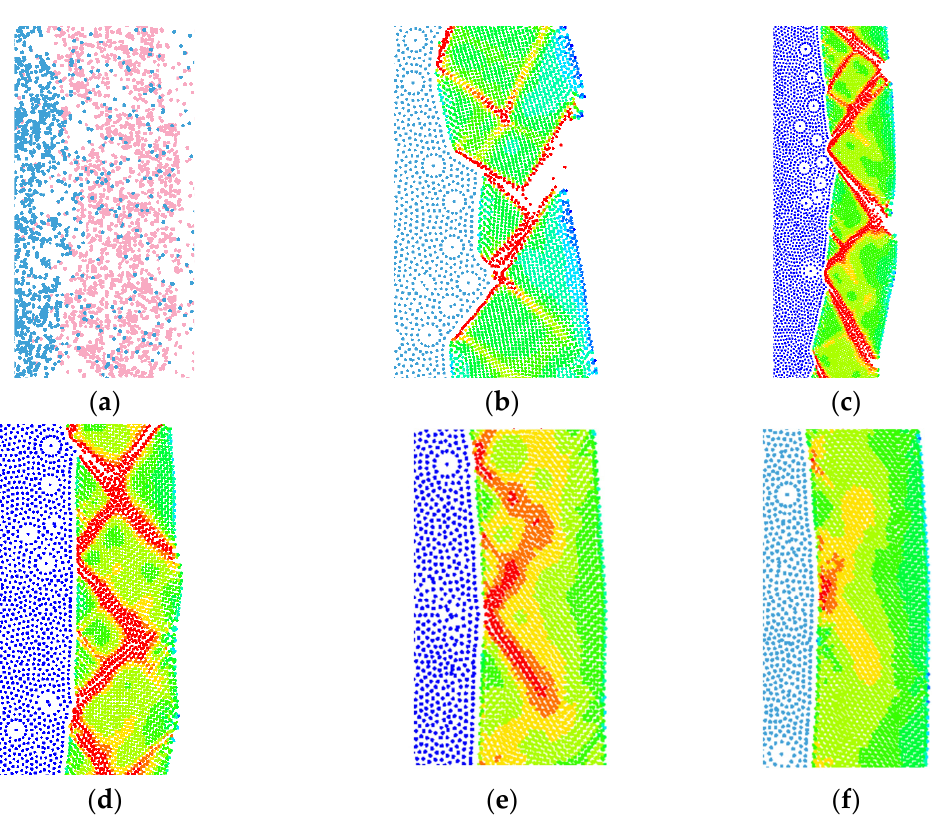
Figure 3. Comparison of the effects of different β values: ( a ) 14.2 µ s, β = 0.8; ( b ) 14.2 µ s, β = 1; ( c ) 14.2 µ s, β = 2; ( d ) 14.2 µ s, β = 3; ( e ) 14.2 µ s, β = 7; ( f ) 14.2 µ s, β = 10.